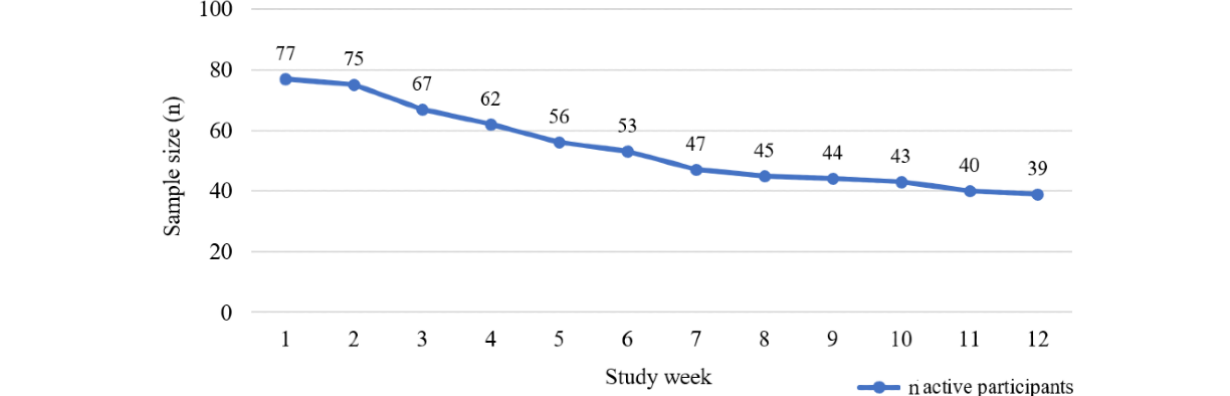
Figure 3. Participation and attrition by week during the intervention